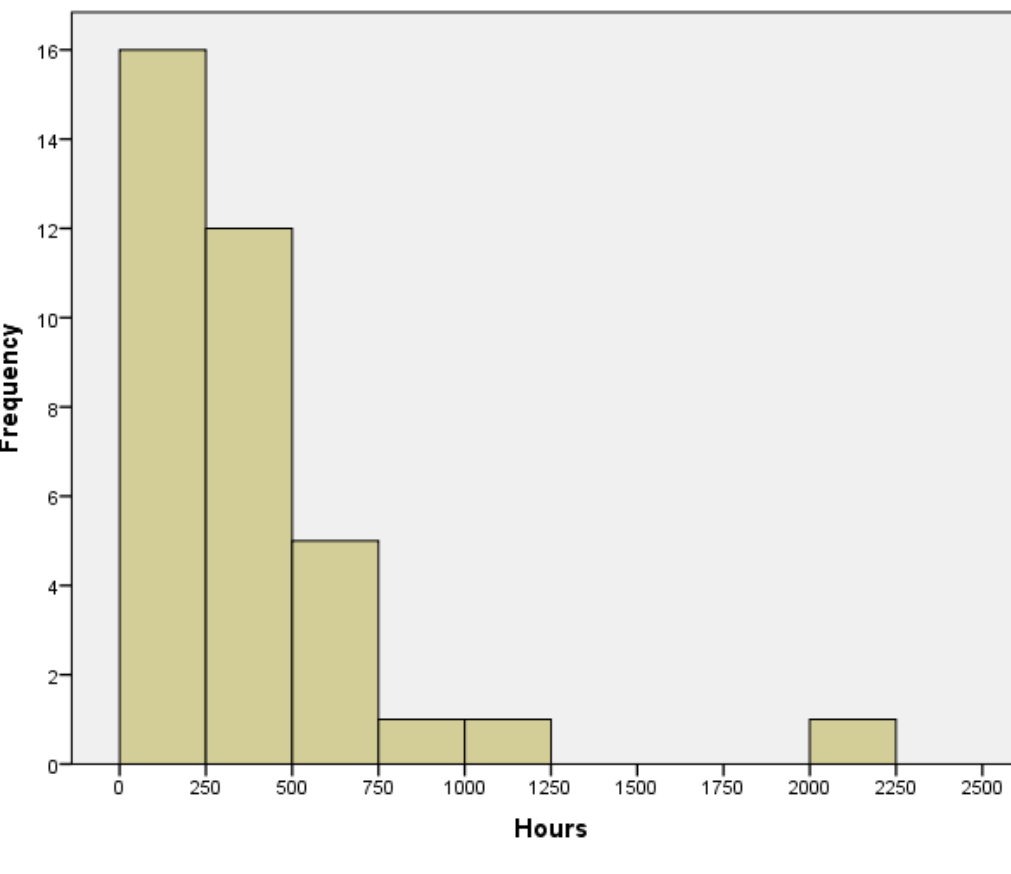
Students were asked to estimate how often they initiated contact with their supervisor, with the options of once a week, once a month, every three months, or less than once every three months. Just over half the students, 19 (56%), stated that they initiated contact with their supervisor at least once a month, 9 (26%) about once every three months, and 5 (15%) less than three times over the dissertation year. One student initiated contact with the supervisor on a weekly basis. There was some variation in the level of satisfaction with the course overall and the amount of time students contacted their supervisor (Table 6). The results suggest that students who initiated contact at least once a month were more likely to have had a positive experience of the course. However these findings were not statistically significant (Fishers exact test = 2.423, p =